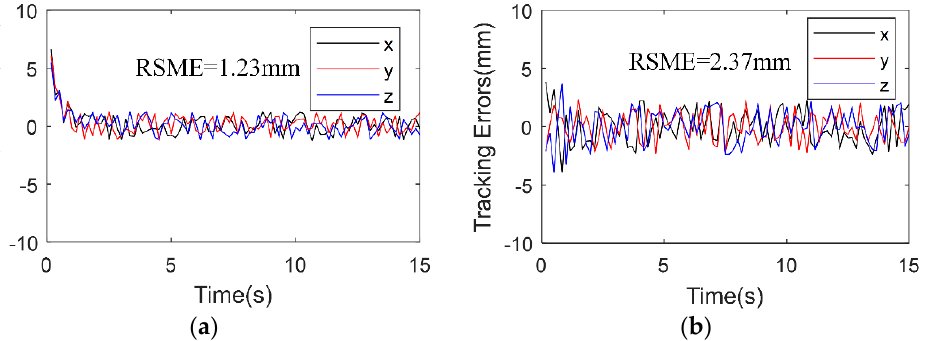
Figure 9. Trajectory tracking variance mean square. ( a ) RMSE of TSM-based controller trajectory tracking. ( b ) RMSE of Trajectory tracking based on PD controller.